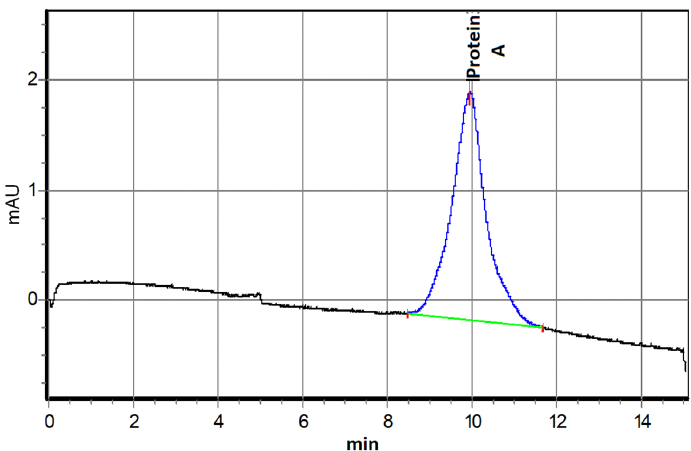
Figure 2. Capillary electrophoresis of 1.28 µM Protein A solution.